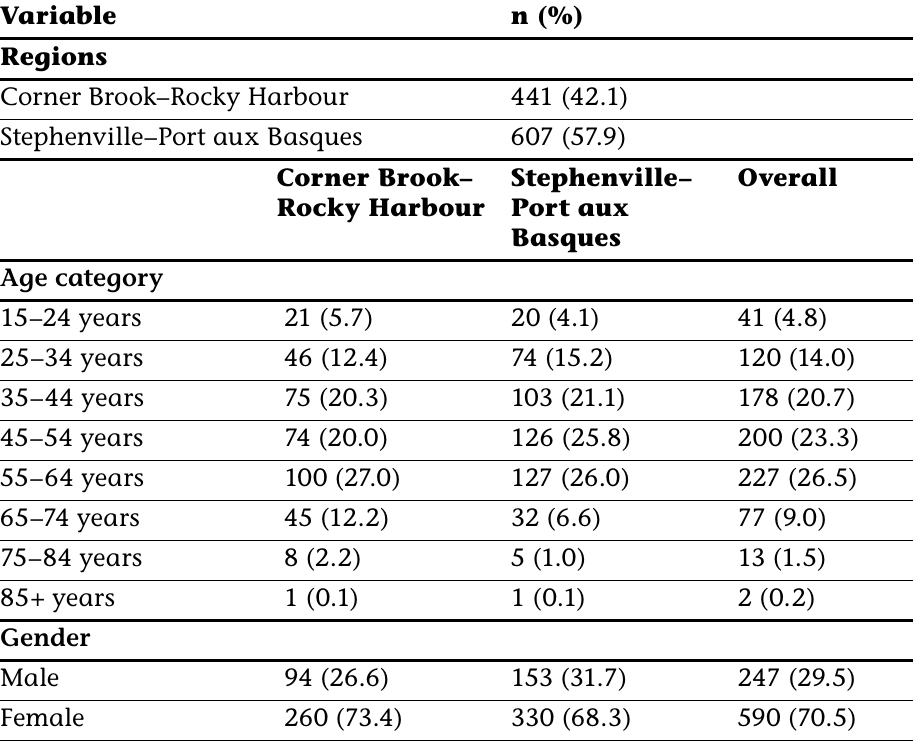
Table 1: Summary of participants’